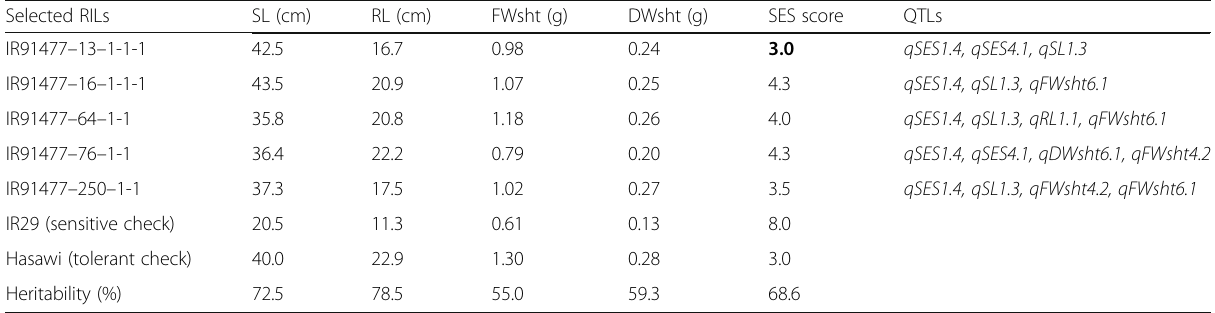
Table 4 Phenotypic values of traits for salt tolerance among selected RILs and parents common in Senegal and Tanzania with their related QTLs Selected